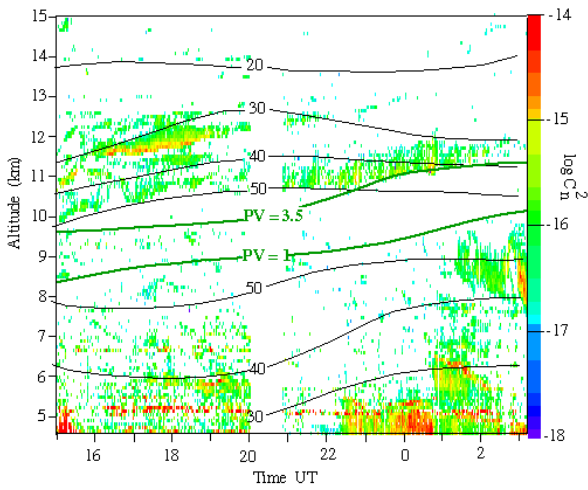
Fig. 8. Time-height cross section of the structure constant C 2 n ob- served by the PROUST radar with a 30m altitude resolution. Also drawn: the wind isotachs (m/s), and the iso-lines PV = 1, giving the lower limit of the fold and PV = 3 . 5 · 10 − 6 m 2 s − 1 K kg − 1 , of- ten considered as a good indicator of the thermal tropopause. This additional information is derived from the ECMWF model. The lack of data between 20:00 and 20:45 UTC is due to an interruption of the radar